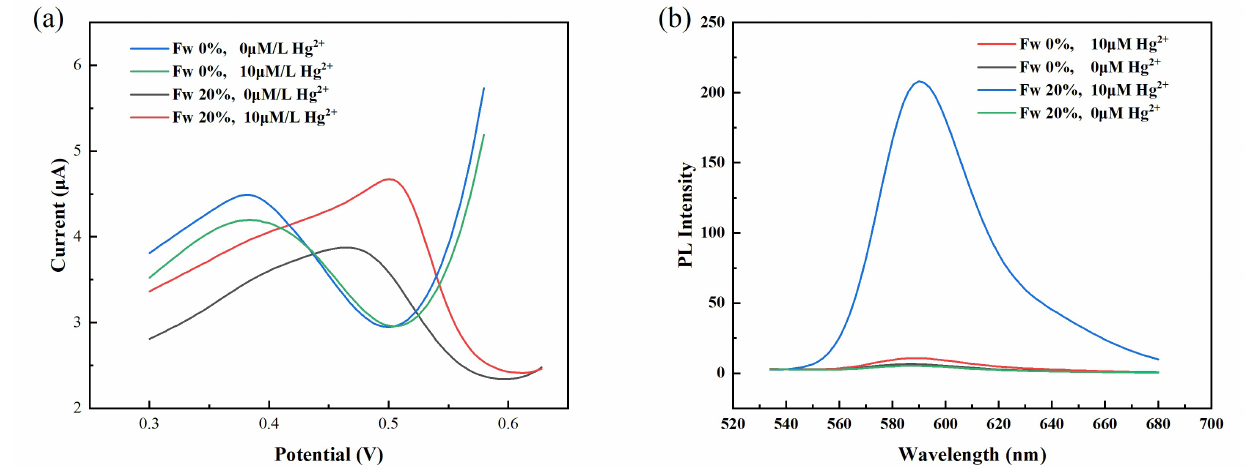
Figure 4. ( a ) the current response curve in ACN buffer and the buffer of water and ACN respectively; ( b ) the PL Intensity curve in ACN buffer and the buffer of water and ACN, respectively. ( Fw = V H